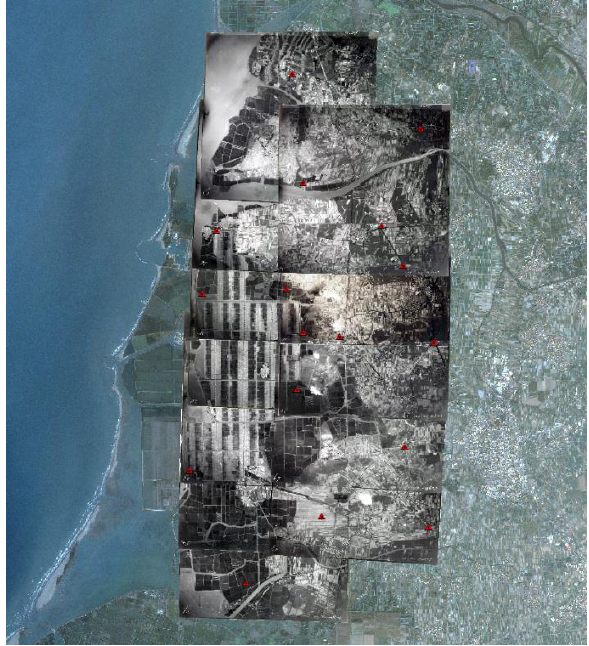
Figure 9. Result of 2D projective